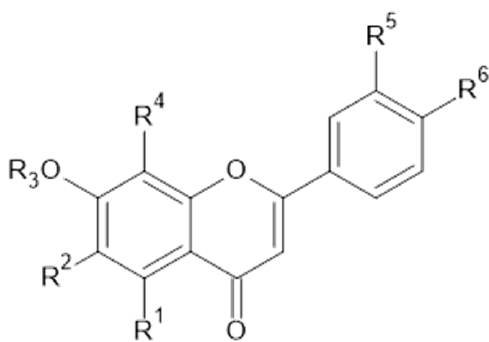
Figure 9. Apigenin and derivatives.